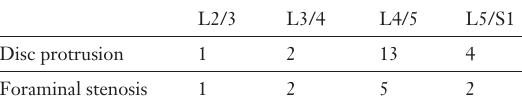
Schematic description of the technique of a selective nerve root block at the level L1-L5 (A). Correct radiculogram of the L5 nerve root after periradicular injection of contrast medium (B).